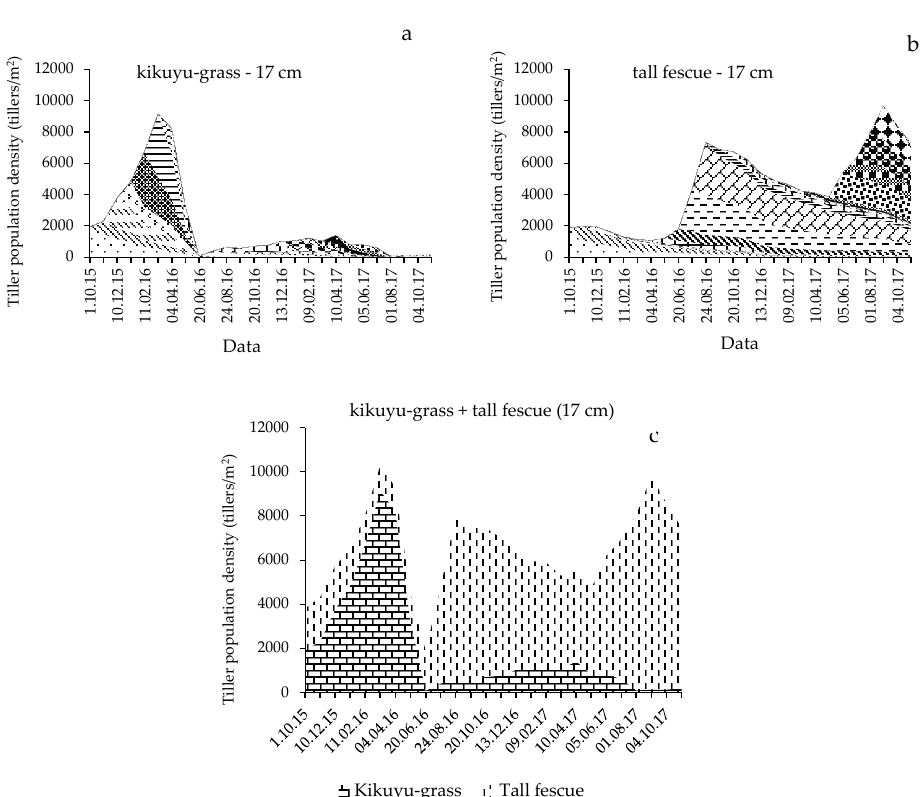
Figure 3. Cohort survival diagrams for tillers of kikuyu-grass ( a ) and tall fescue ( b ) cultivated in mixed canopies maintained at 17 cm and their overlapping population demography ( c ). On the other hand, tall fescue presented an inverse pattern of response to those observed for kikuyu-grass plants, with their population increasing from the beginning to the end of the experimental period, regardless of the treatment condition. In addition, the tall fescue population overlapped the kikuyu-grass population as the canopy height increased. It was also observed that the pastures managed at the heights of 12 and 12/7 cm, as well as those managed at the heights of 17 and 17/7 cm, presented similar results.